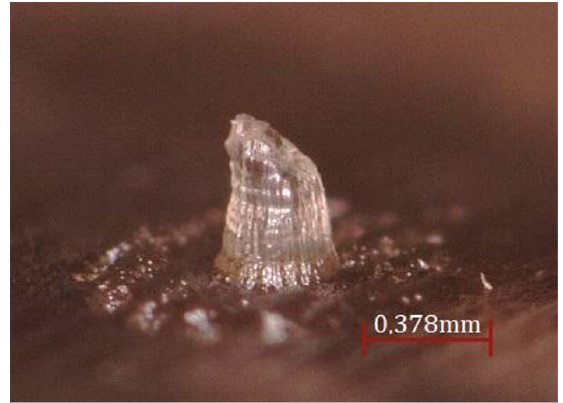
Figure 6. Patch MN.